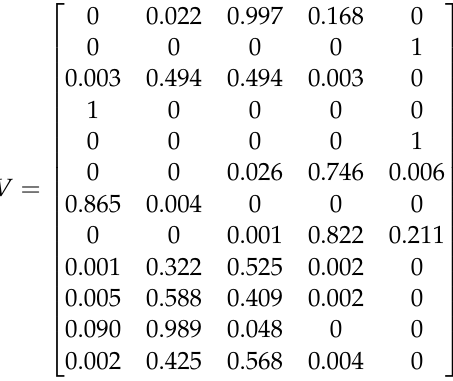
Figure 4. ( a ) Cloud drops graphs of C 3 Fire severity belonging to each level; ( b ) Cloud drops graphs